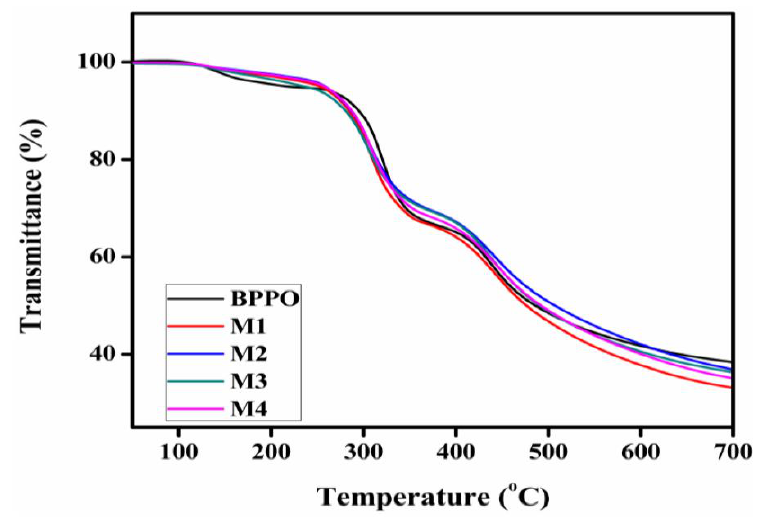
Figure 10. Thermal gravimetric analysis (TGA) thermograms for various porous BPPO-based mem- branes.